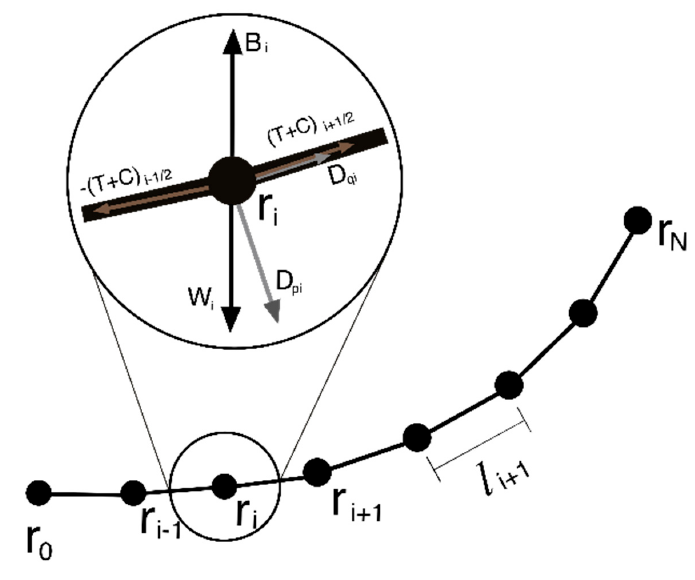
Figure 4. Line discretization and forces are acting on a node.